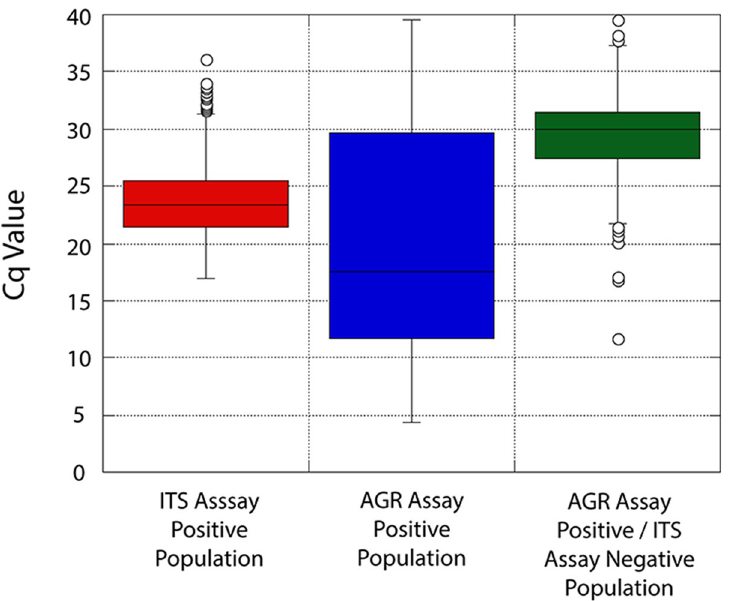
Fig 3. Boxplots of positive sample populations from field-collected samples. Plots represent the total population of ITS-assay-positive samples (n = 349), the total population of AGR-assay-positive samples (n = 643), and the population of ITS-assay-negative, AGR-assay-positive samples (n = 296). Medians are depicted by the horizontal lines, while the box for each plot represents the interquartile range (IQR), and whiskers represent Q3 + (1.5)(IQR) and Q1 – (1.5) (IQR).